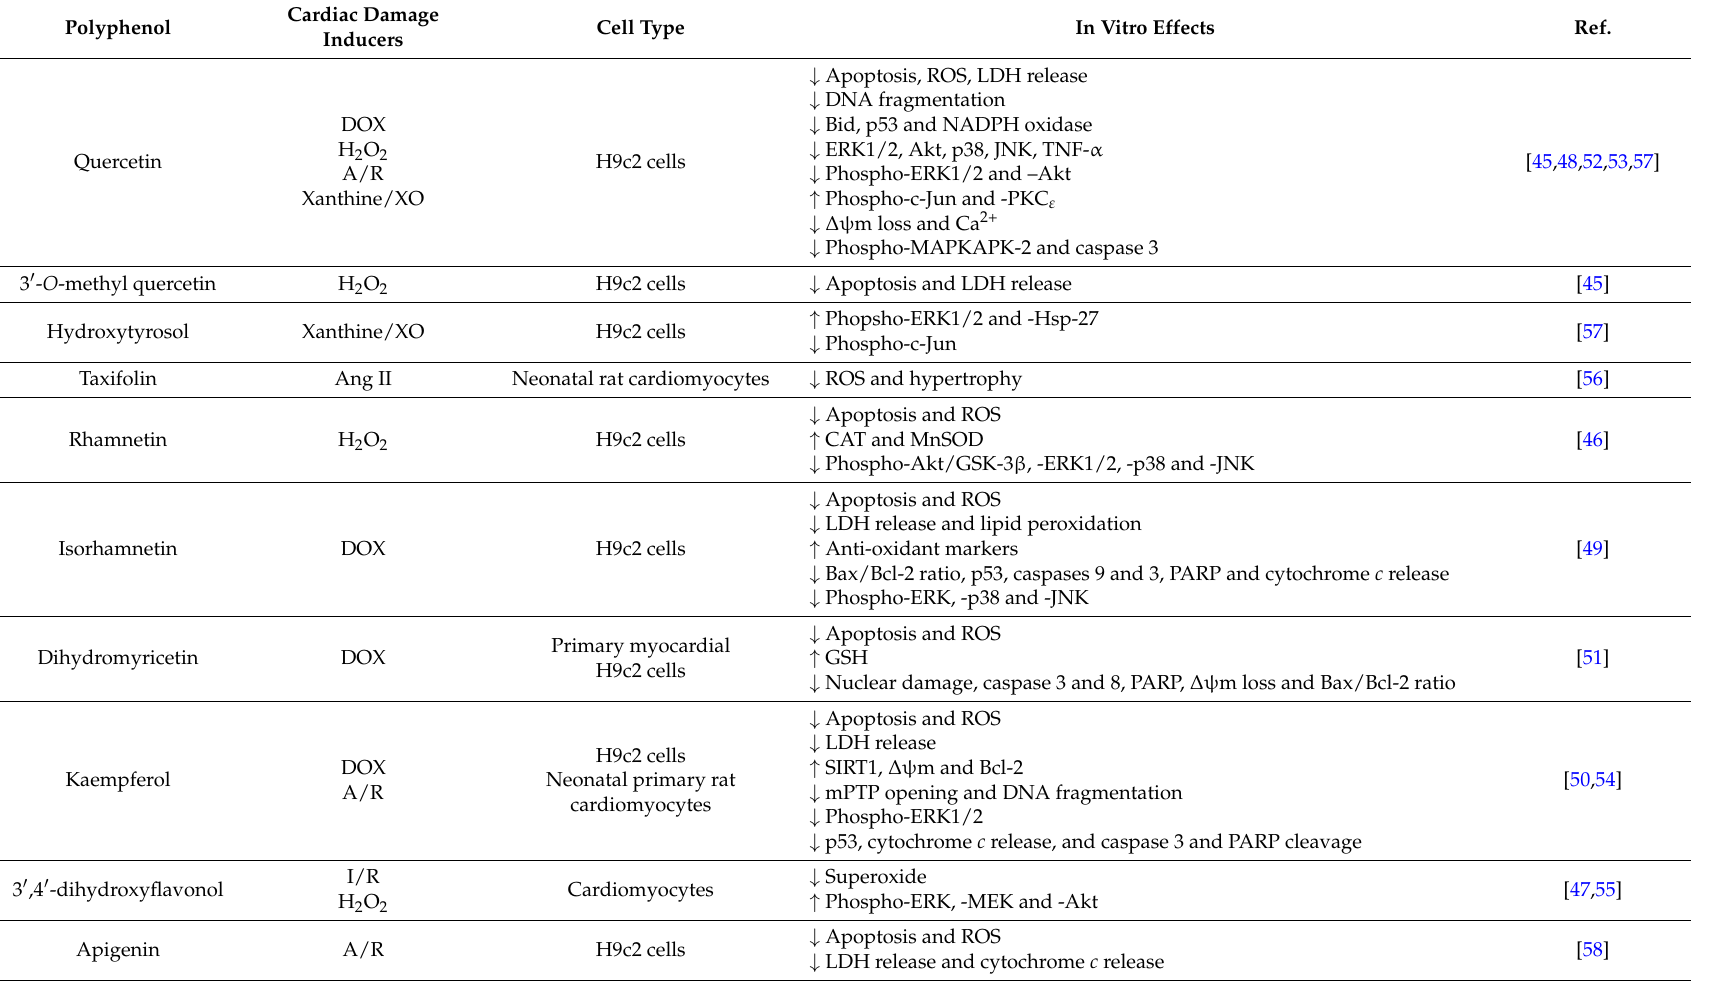
Table 1. In vitro protective effects of polyphenols against the oxidative stress-induced cardiotoxicity. Polyphenol In Vitro Effects